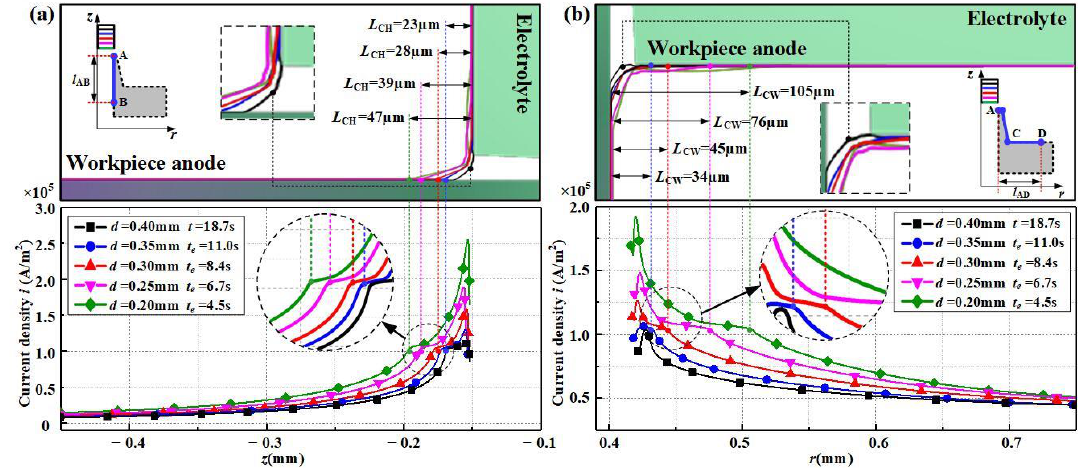
Figure 10. Influence of initial machining gap: ( a ) Current density distribution of l AB ; ( b ) Current density distribution of l AD .